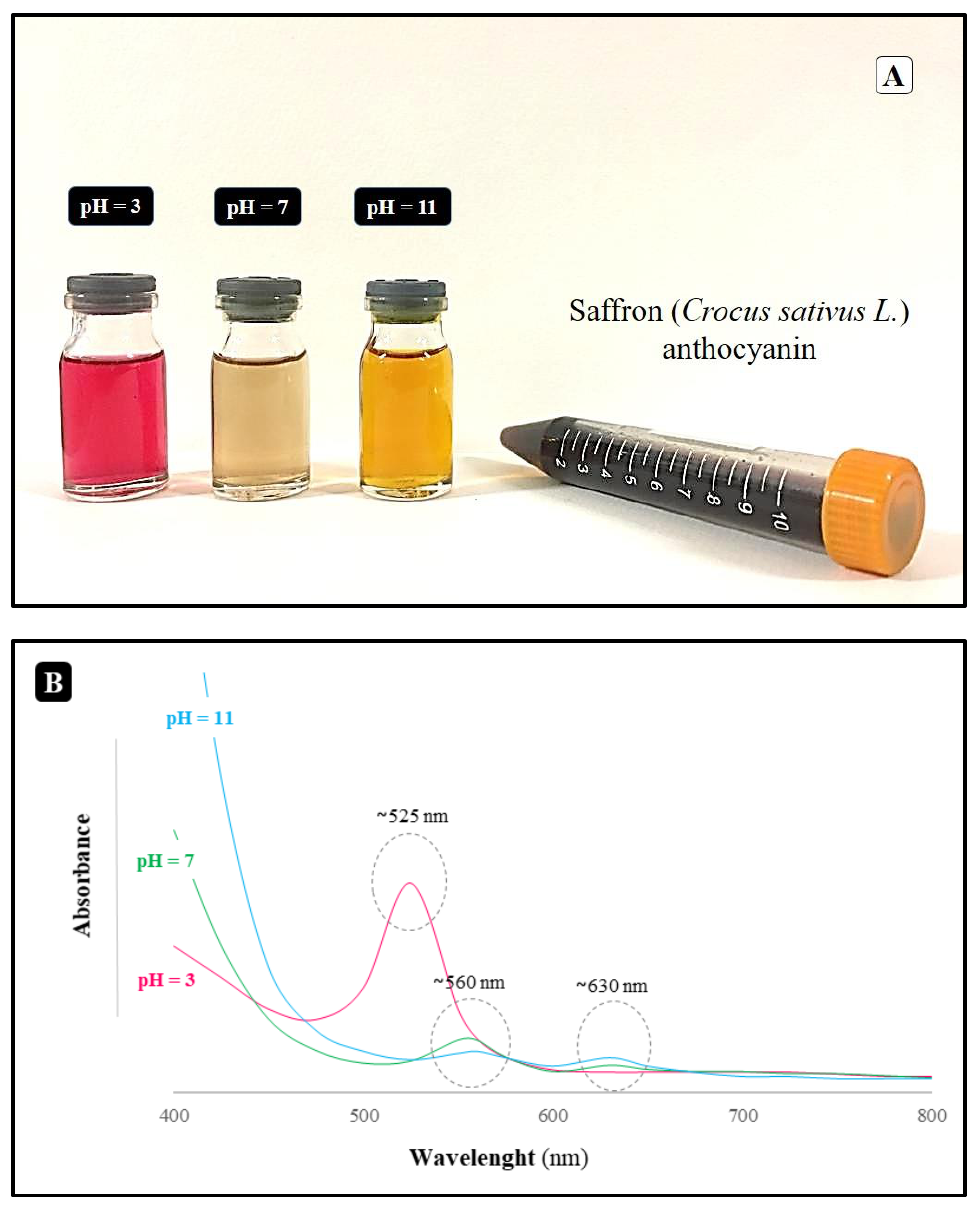
Figure 2. The pH-dependence of ( A ) solution color variations and ( B ) UV/Visible spectra of SA As were measured in various buffer solutions.